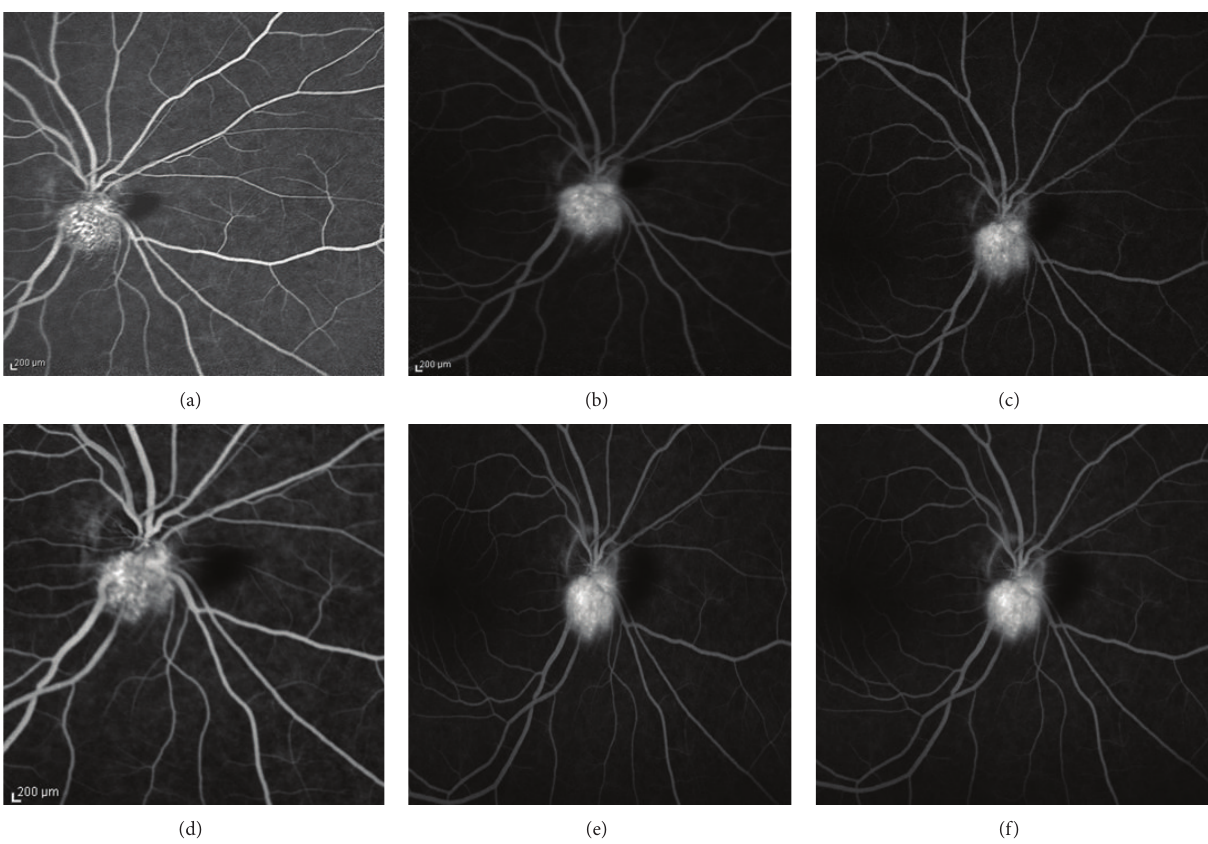
Figure2:(a)Through.(c)Fluoresceinangiographyearlyandlatephasethreemonthsafterphotodynamictherapy.(d)Though.(f)Fluorescein angiography early and late phase one year after photodynamic therapy, showing stability of the lesion.